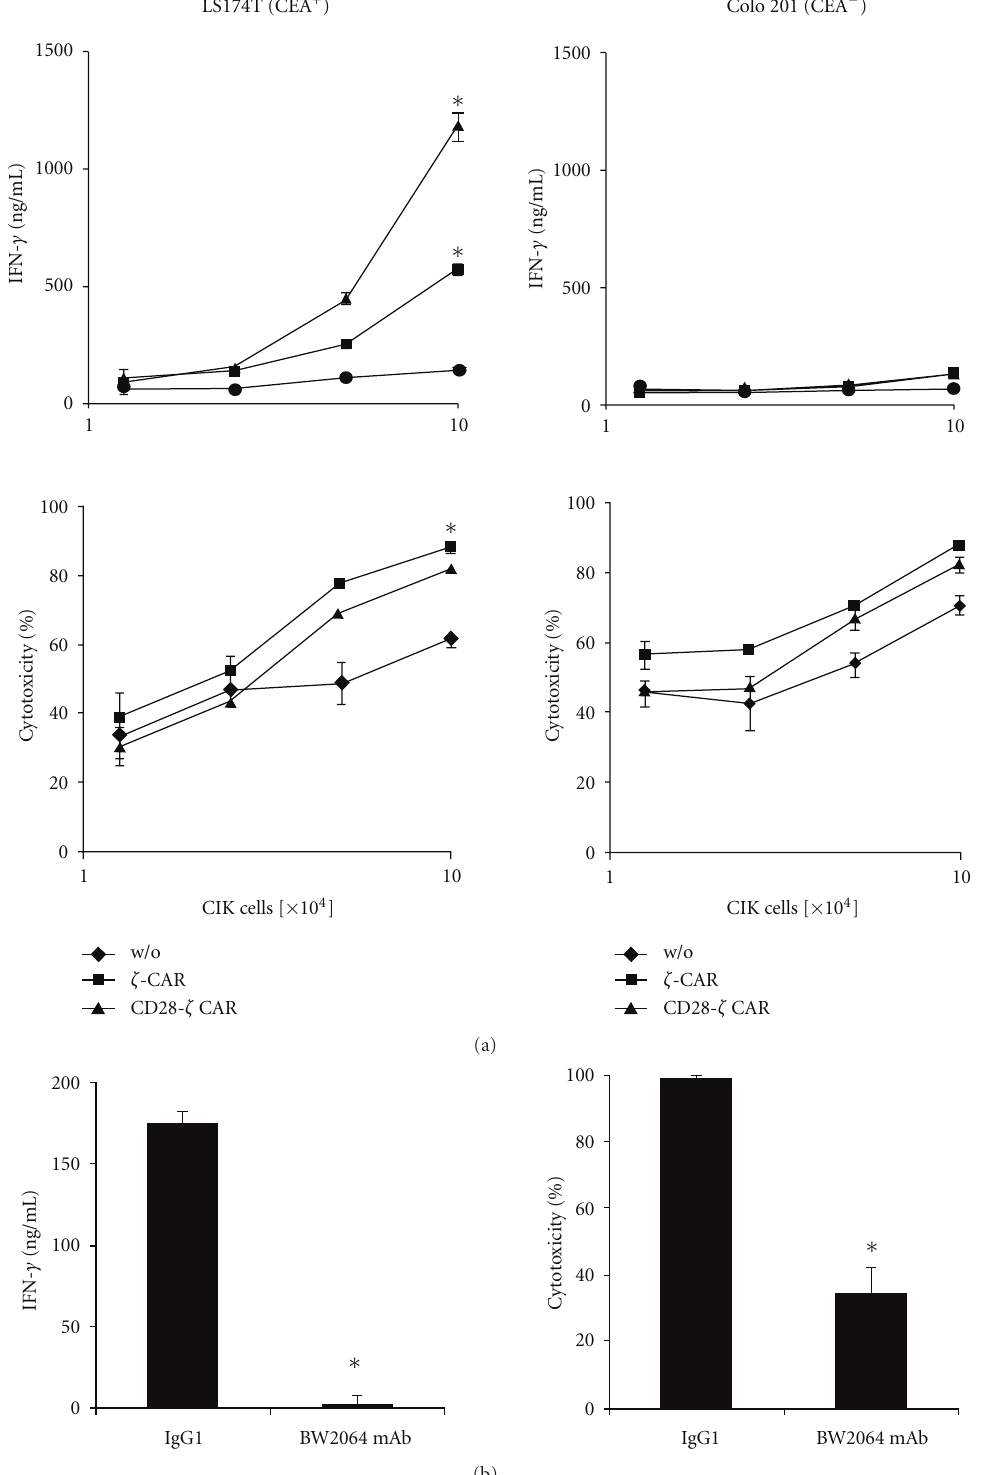
Figure 3: CAR engagement produces higher activation of engineered CIK cells toward colorectal carcinoma cells. (a) CIK cells were engineered with the CEA-specific ζ or CD28- ζ CAR (1–10 × 10 4 CAR + cells/well) and incubated for 48 hrs with CEA + LS174T and CEA − Colo201 cells (5 × 10 4 cells/well). Mock-modified CIK cells without CAR (w/o) served as control. IFN- γ secreted by activated CIK cells into the culture supernatants was recorded by ELISA (upper), and cytolysis of tumour cells was monitored using the XTT-based viability assay (lower). ∗ P < 0 . 05 compared to nonmodified CIK cells (w/o). (b) To block the CEA-specific CAR binding domain, CIK cells with ζ CAR were incubated in presence of the anti-idiotypic antibody BW2064, which binds to the CAR BW431/26-scFv domain, or with an isotype- matched IgG1 control antibody of irrelevant specificity together with CEA + LS174T tumour cells for 48hrs. IFN- γ secreted into the culture supernatant and specific cytotoxicity toward LS174T cells were monitored. Data show a representative experiment out of three. ∗ P < 0 .